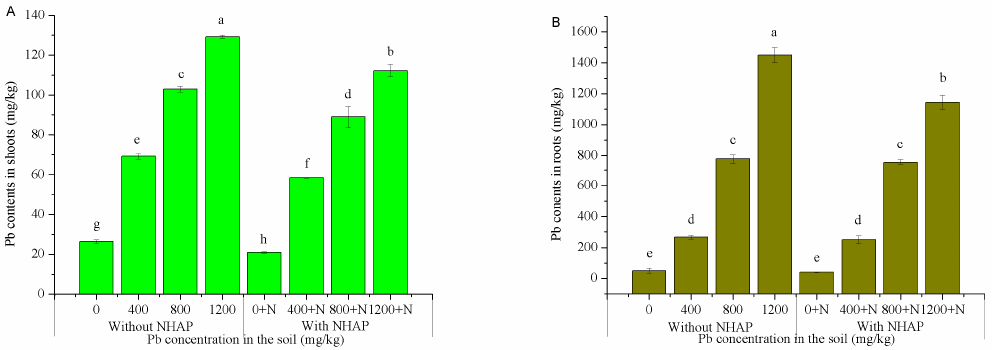
Figure 2. Effects of NHAP on Pb contents in shoots ( A ) and roots ( B ). a–h: The different letters in the figure represent significant differences between treatments at p < 0.05.